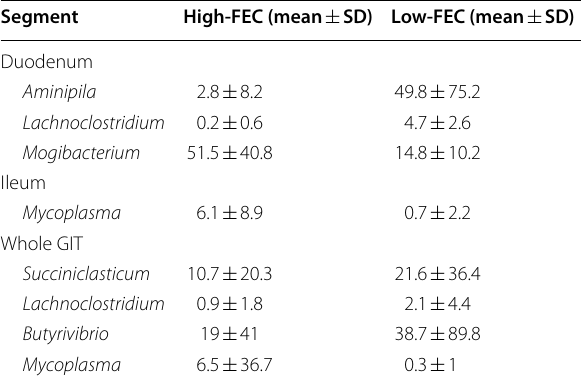
Table 2 Bacterial genera showing significant differences in abundance between individual gastro-intestinal segments, as well as the whole gastro-intestinal tract (GIT), of High- and Low- FEC